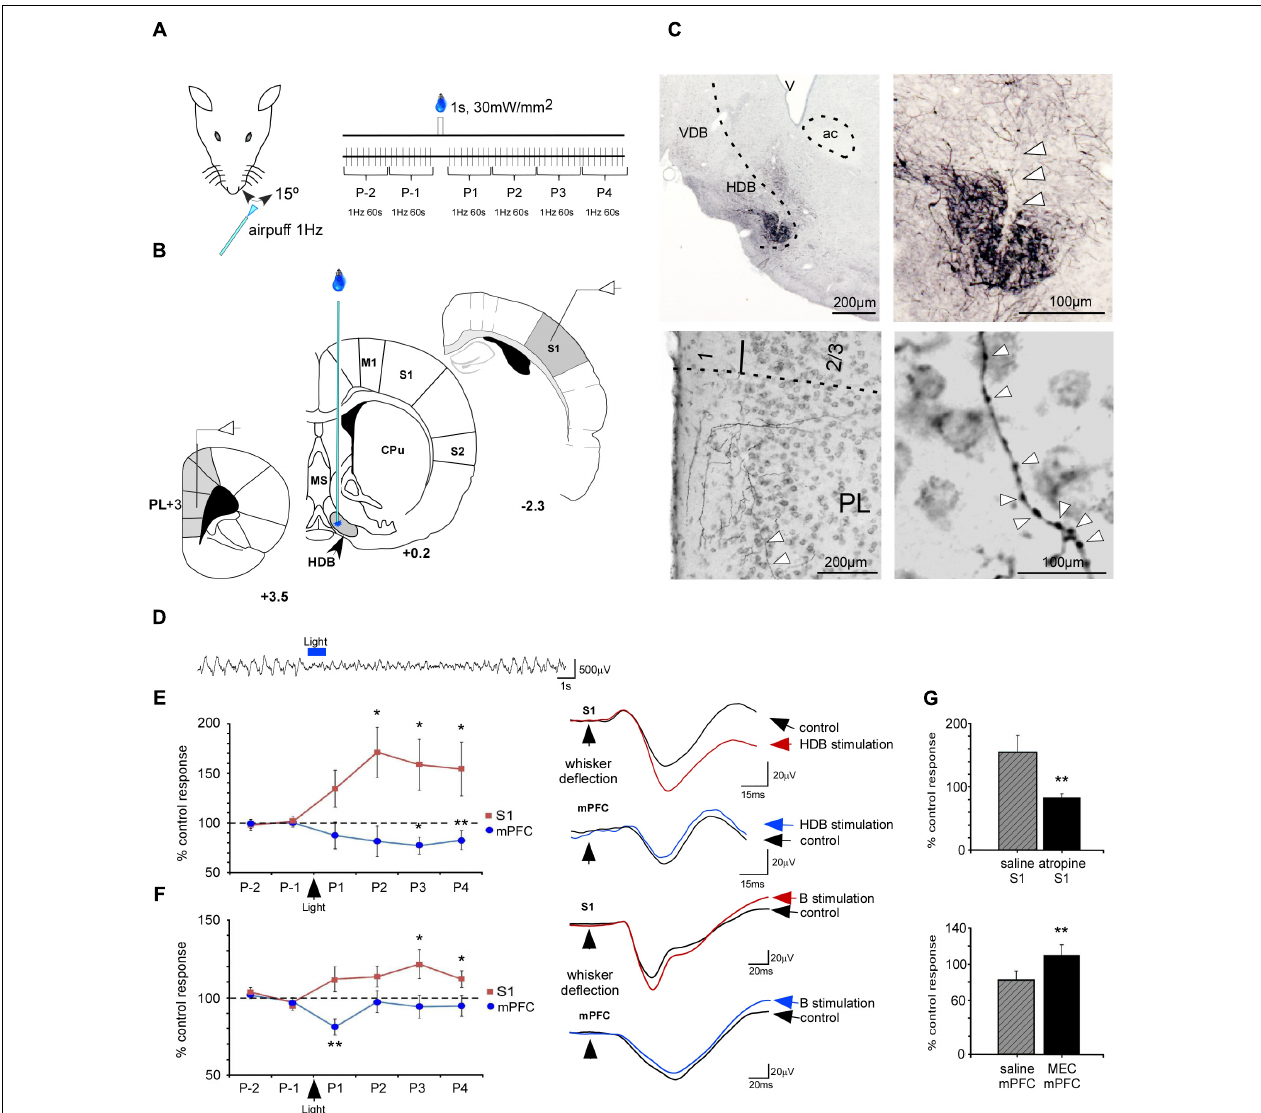
FIGURE 10 | Optogenetic stimulation of BF induced cholinergic modulation of whisker responses in S1 and mPFC cortices. (A) Diagram of the experimental protocol. Tactile stimulation (air puffs) was applied to the trimmed contralateral whiskers. (B) Schematic drawing of location of stimulating and recording electrodes. (C) A representative case of virus injection [AAV5-CaMKIIa-hChR2(H134R)-EYFP] in HDB. Microphotographs of the injection site are shown in the upper part. Arrowheads indicate the cannula track. In the lower part of the figure microphotographs showing fibers and axonal varicosities (arrowheads) are shown. (D) A typical effect of HDB light stimulation on the S1 EEG. The light induced an EEG desynchronization. (E) Plot of SEP area in controls (2 min) and during the 4 min after HDB blue light stimulation (1 s pulse duration). Note that HDB stimulation induced different simultaneous responses in S1 and mPFC cortices. (F) Plot of SEP responses in control (2 min) and during the 4 min after blue-light stimulation (1 s pulse duration) in the B nucleus. Note that B stimulation induced different responses in the S1 and mPFC cortices. The blue-light induced inhibition in mPFC lasted less than when the light was applied to the HDB. Examples of the SEP are shown on the right. (G) The increment of the SEP response in S1 cortex evoked by HDB stimulation was blocked by atropine sulfate (5 mg/kg) injected 10 min before blue-light stimulation (upper plot). The inhibition of SEP response in mPFC cortex evoked by HDB stimulation was blocked by mecamylamine (8 mg/kg; MEC) injected 10 min before blue light stimulation (lower plot). In (E,F) the mean of the two control values was considered as 100%. Inset in (A) indicates evoked potential area (green). ∗ p < 0.05; ∗∗ p < 0.001.